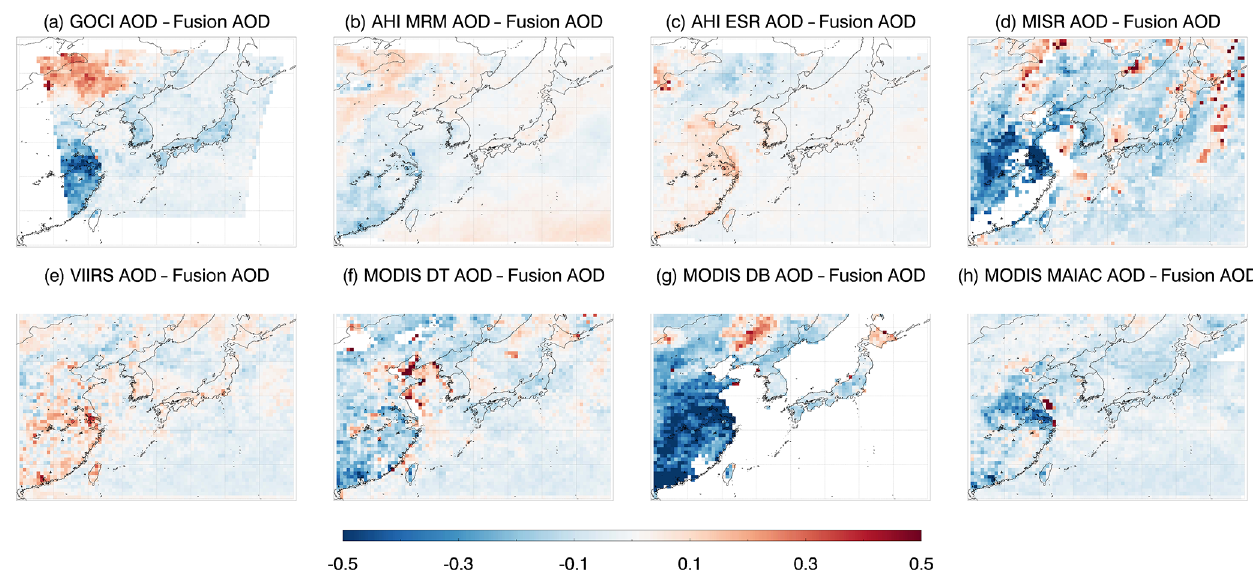
Figure 11. Difference between campaign period mean gridded AOD of (a) GOCI, (b) AHI MRM, (c) AHI ESR, (d) MISR, (e) VIIRS, (f) MODIS DT10K, (g) MODIS DB, and (h) MODIS MAIAC and mean of fusion AOD during the KORUS-AQ campaign period (1 May to 12 June